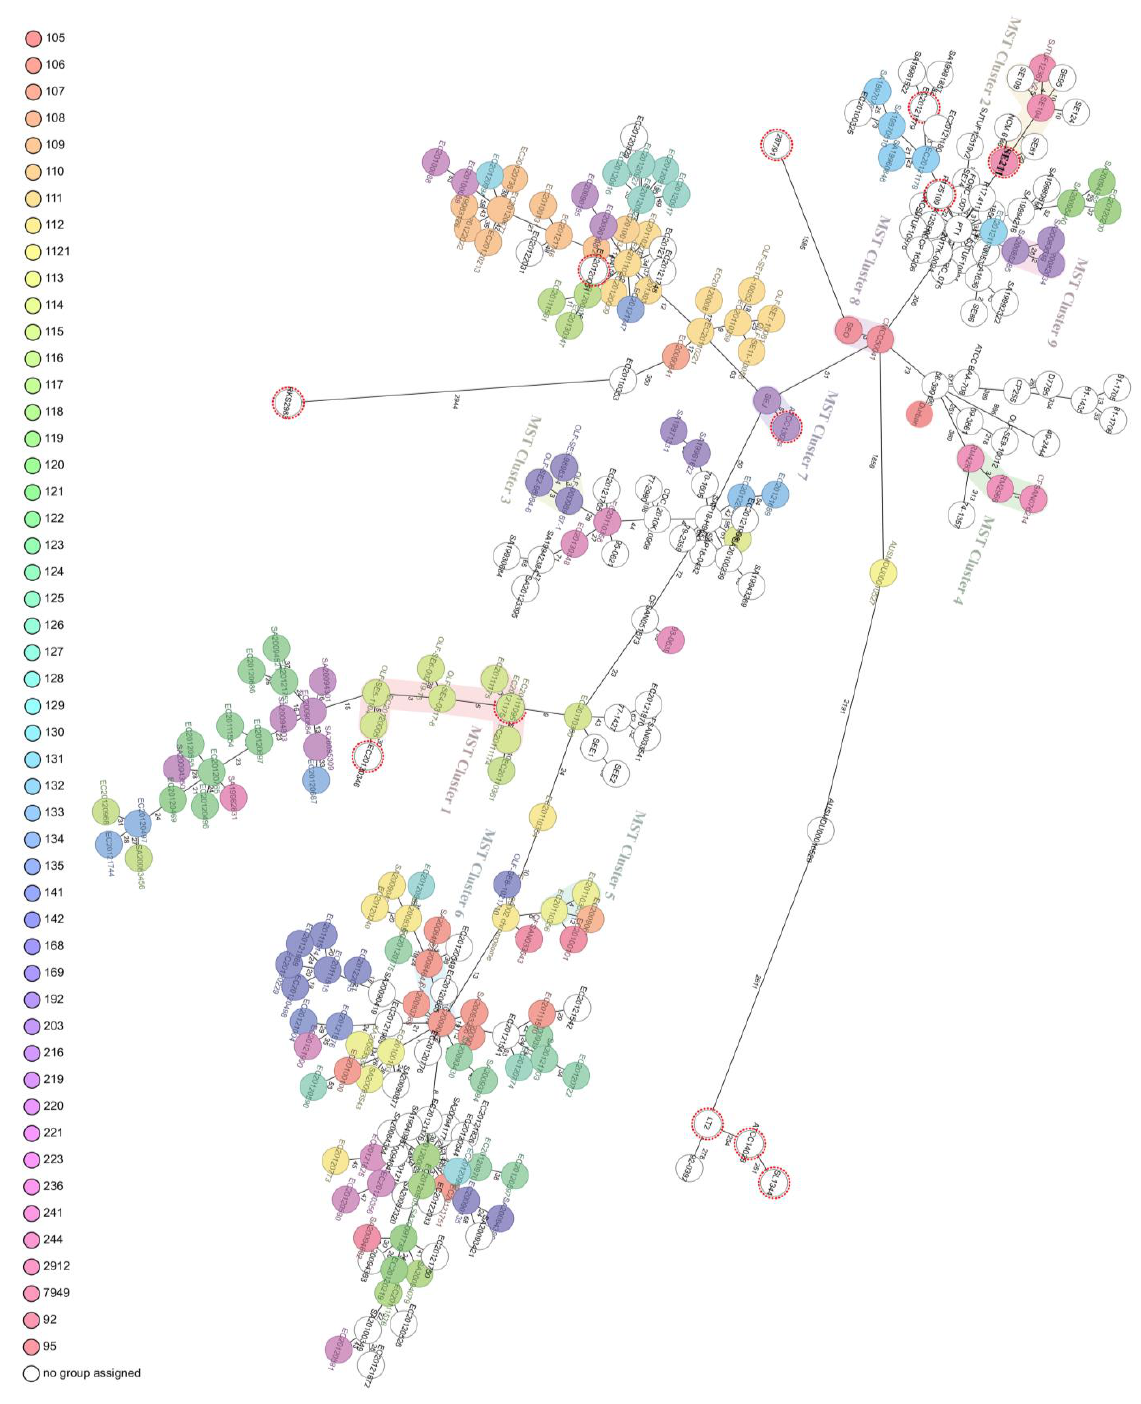
Figure 4. Minimum spanning tree (MST) diagram of 255 Salmonella enterica genome samples. In this project included 249 S. Enteritidis (three samples with missing values were excluded), a S. Gallinarum, three S. Typhimurium, a S. arizonae and SE211 genome were included. 255 genome samples were represented by these single nodes based on their genotypes and the links between the nodes are based on the distance of the genotypes. The color groups were set according to the cgMLST type. Additionally, there were nine clusters highlighted by different background colors and the name of these clusters were shown as label. The cluster distance threshold is seven alleles difference and at least one other member of the